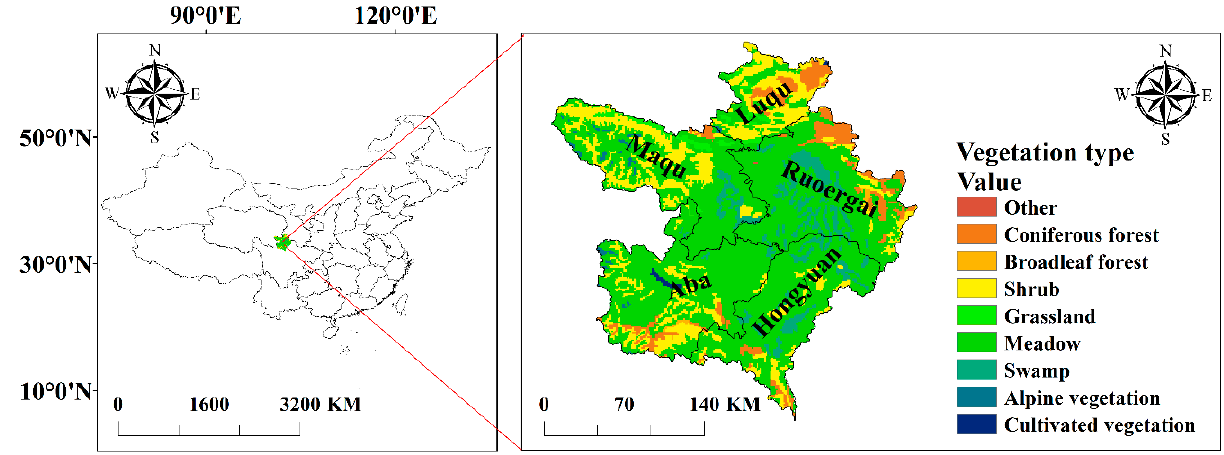
Figure 1. The location of the study area in China and the vegetation types of the Ruoergai wetland area (RWA).